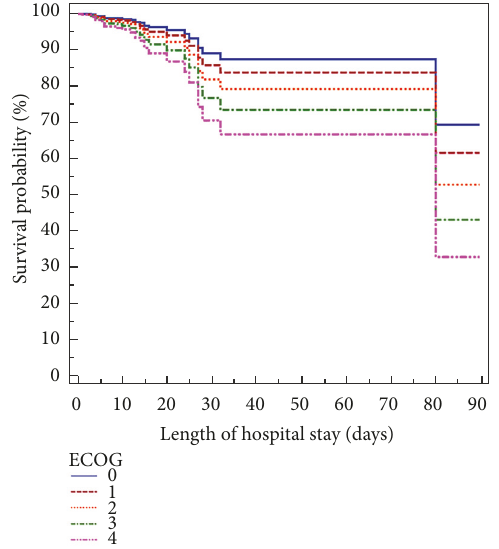
Figure 3: Survival probabilities in postsurgical cancer patients without infection, according to the Eastern Cooperative Oncologic Group (ECOG)